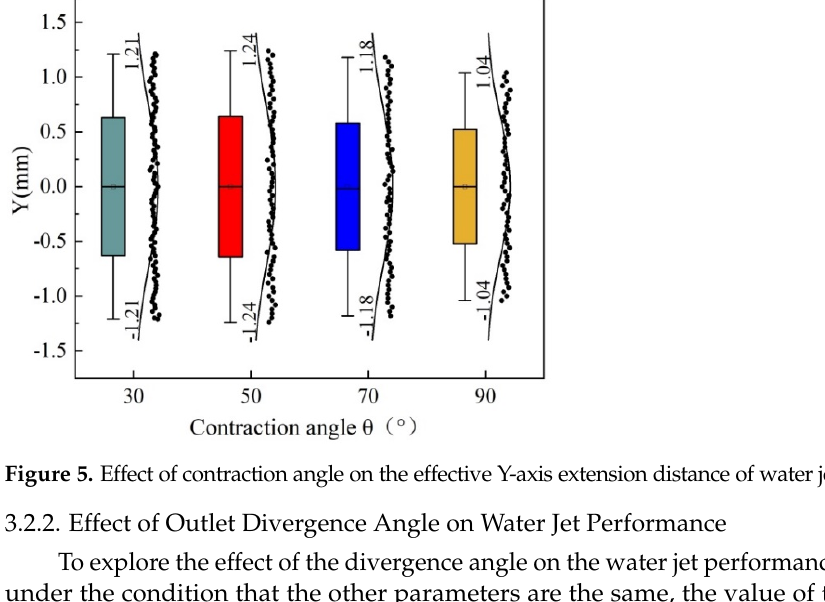
Figure 4. Effect of contraction angle on the X-axis velocity attenuation of water jet.